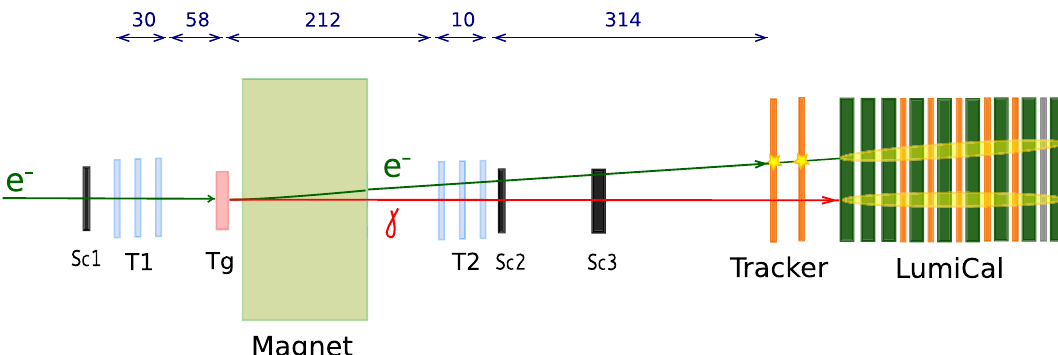
Fig. 5 Geometry of the beam test setup (not to scale). Sc1, Sc2 and Sc3 are scintillator counters; T1 and T2 the arms of three-pixel detector planes, Tg the copper target for bremsstrahlung photon production and